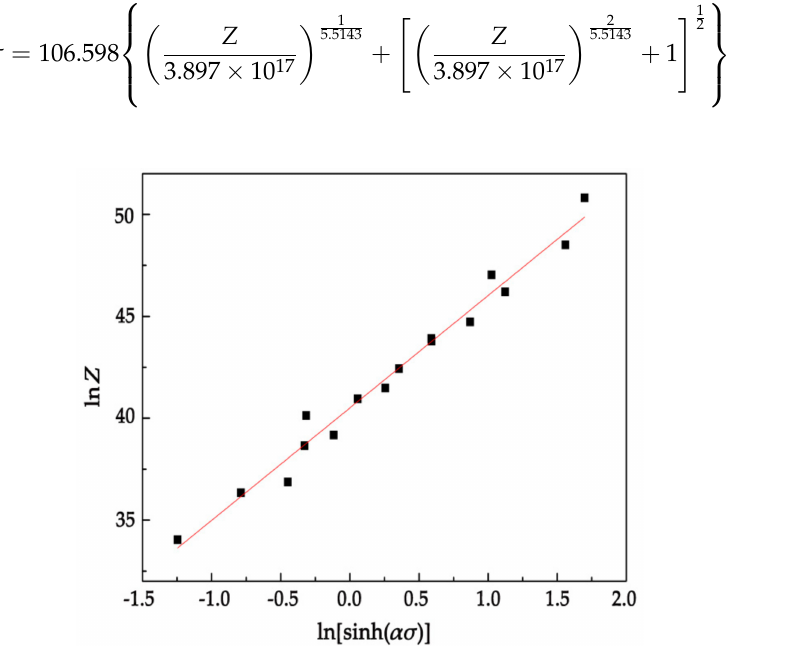
Figure 9. Relationship between the Zenner-Hollomon parameter: ln Z − ln [ sinh ( ασ )]